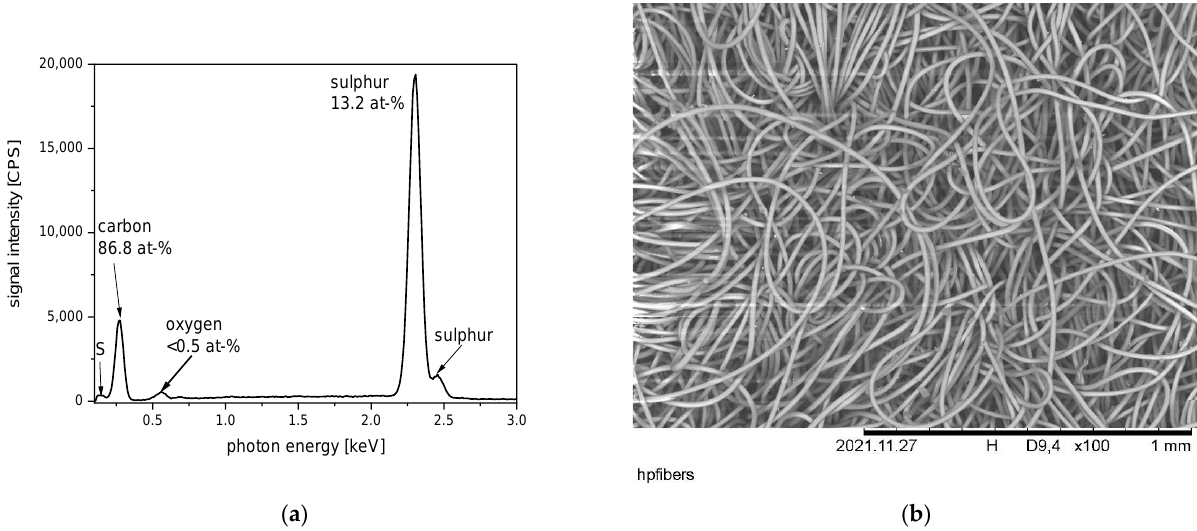
Figure 12. PPS sample from a non-woven filter material—( a ) EDS spectrum; ( b ) SEM image. The second PPS fiber sample is modified by a fluoro carbon finish, probably applied